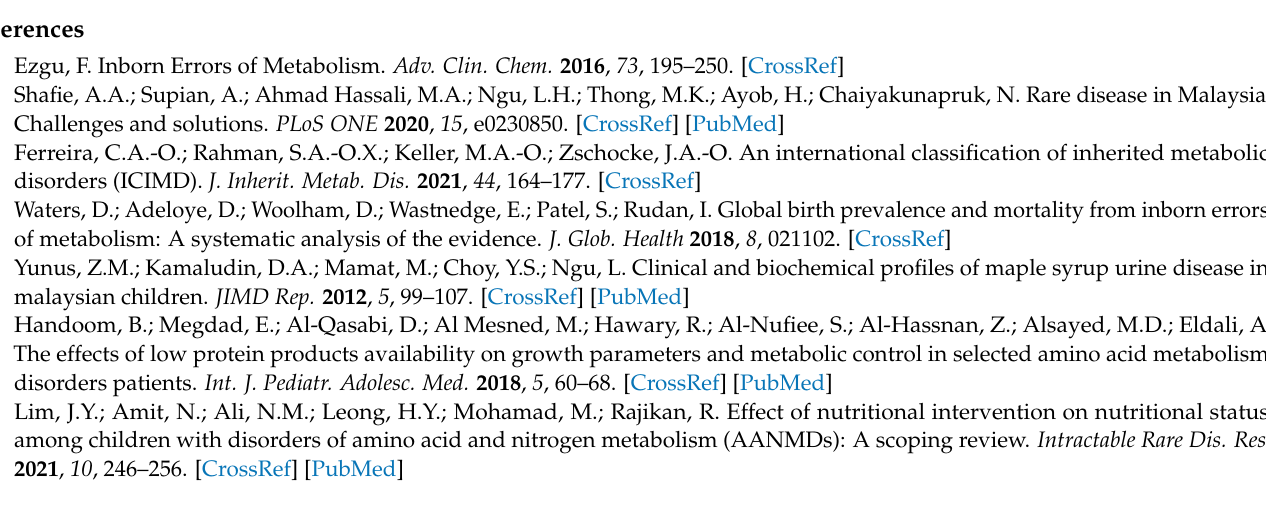
Table S2: Facilitators towards dietary